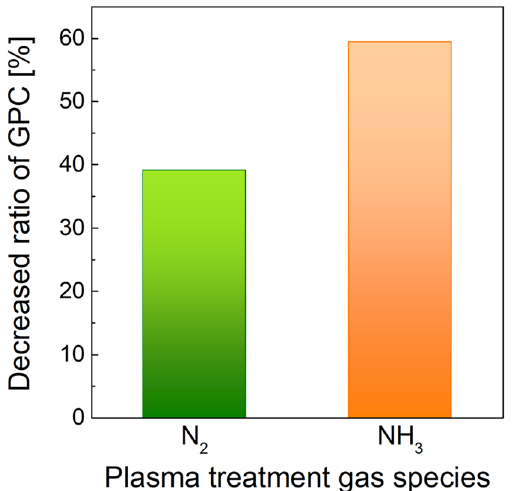
Figure 1. Decreased GPC ratio of SiO 2 PE-ALD with N 2* and NH 3* compared with the no inhibitor case.